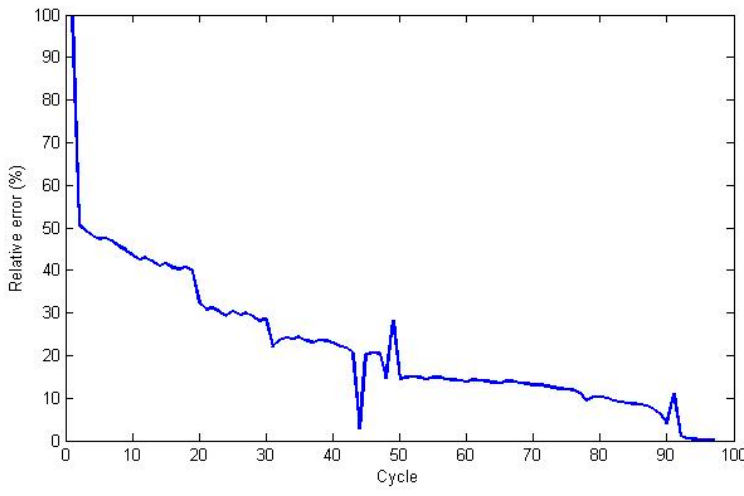
Figure 12. EOL prediction error in cell B0007.